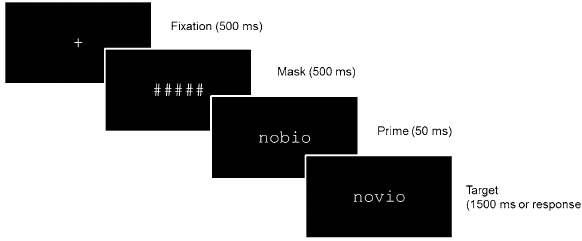
Figure 4. Schematic representation of a trial of Experiment 1 (semantic categorization